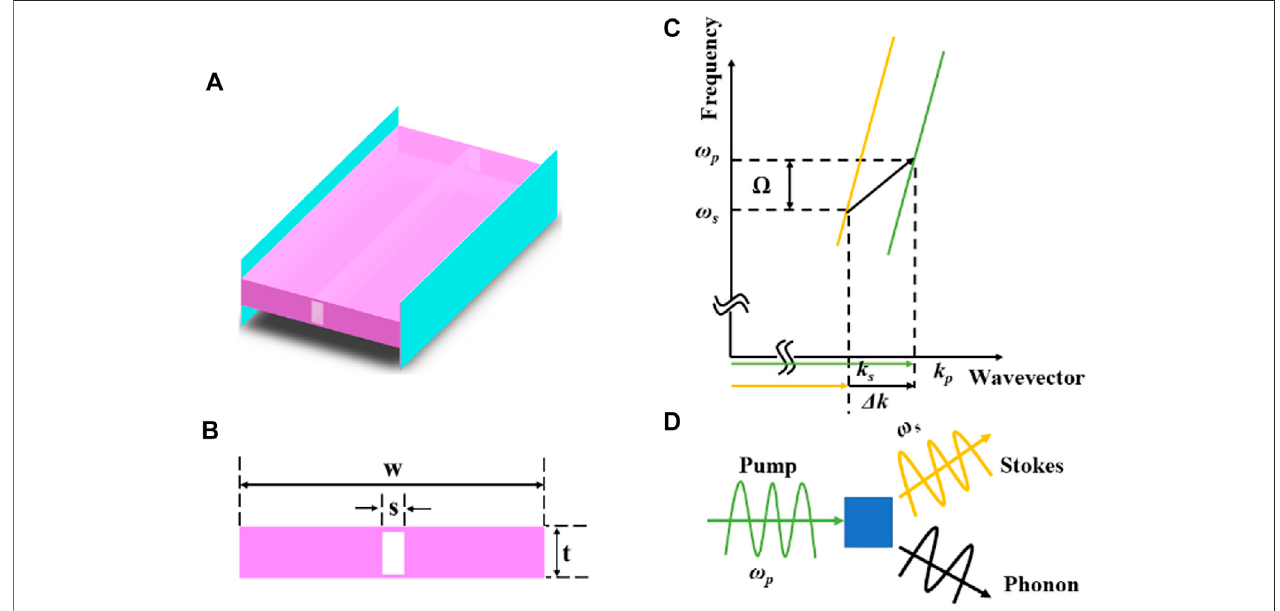
FIGURE1|(A) Schematicdiagramofthesuspendedwaveguidestructure. (B) Frontviewofthesuspendedwaveguidehighlightingtheinternalairslot; t =215 nm, w = 800 nm, air slot length s = 2 nm. (C) Frequency-wavevector plot showing the interaction of the pump, Stokes and phonon waves in the FSBS process; the optical curves represent the optical resonances generated for different spatial modes. (D) Schematic diagram of the generation of Stokes and phonon waves produced by the annihilation of a pump wave.